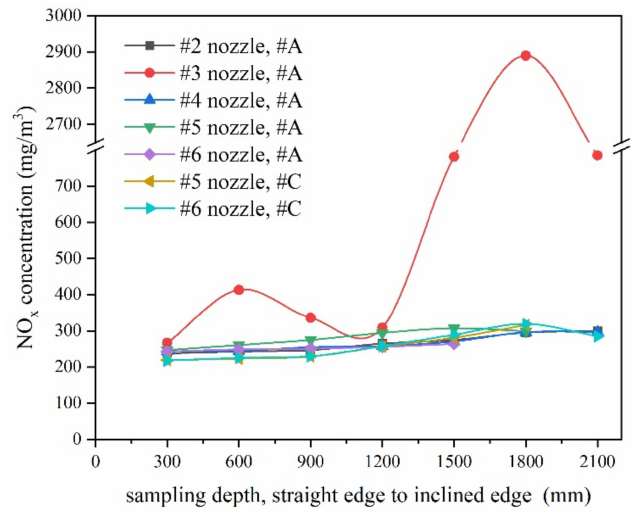
Figure 10. Horizontal distributions of NO x concentration at the different heights of the #A and #C SNCR